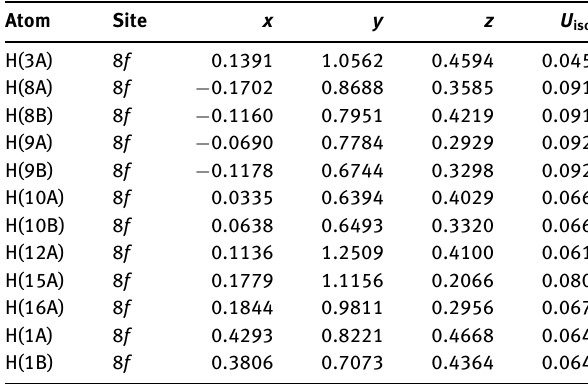
Table 2: Fractional atomic coordinates and isotropic or equivalent isotropic displacement parameters (Å 2